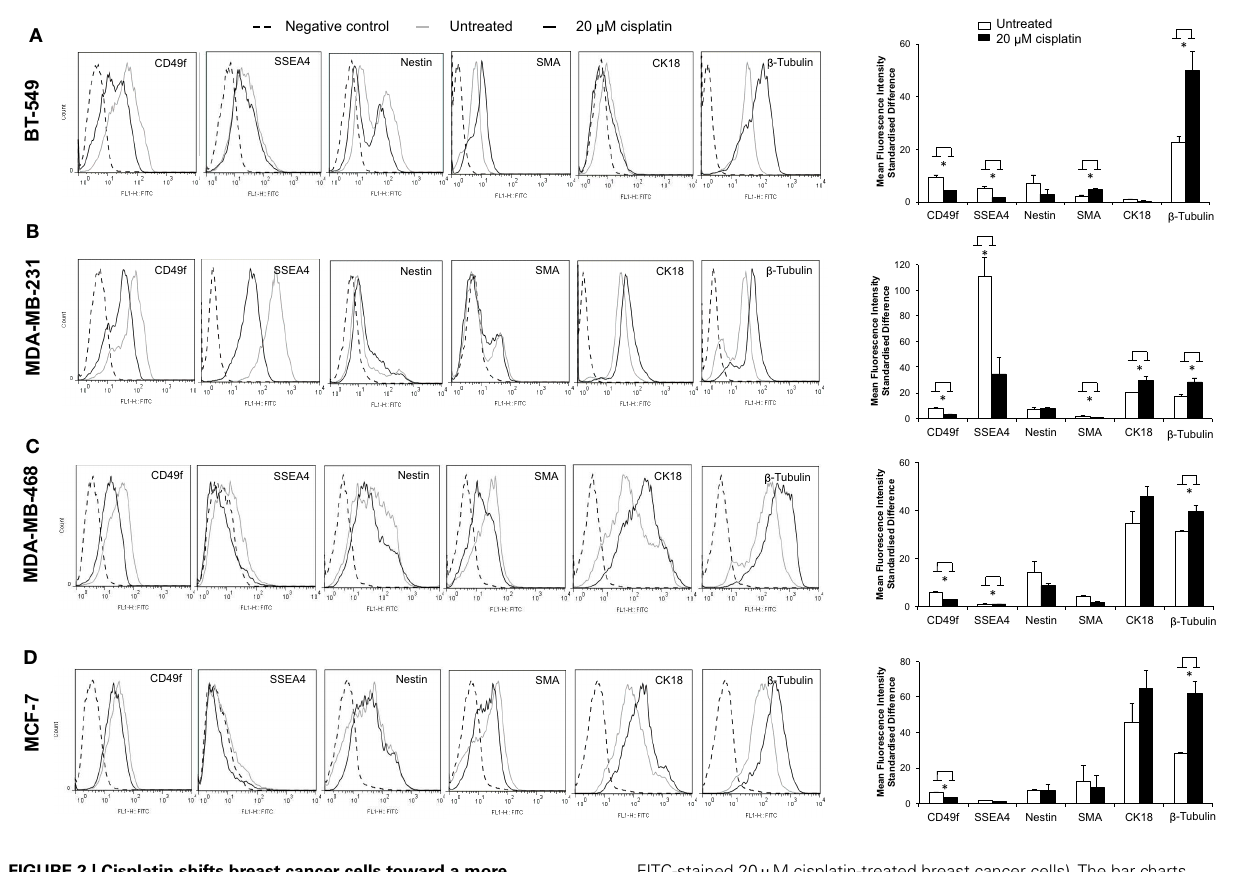
FIGURE 2 | Cisplatin shifts breast cancer cells toward a more differentiated phenotype . Flow cytometric quantification of CD49f, SSEA4, nestin, SMA, CK18, and β -tubulin protein expression showed various levels in four breast cancer cell lines. (A–D) show flow cytometry histograms of expression of the above markers in BT-549, MDA-MB-231, MDA-MB-468, and MCF-7 (black dashed line: unstained control; gray line: FITC-stained untreated breast cancer cells; black line: